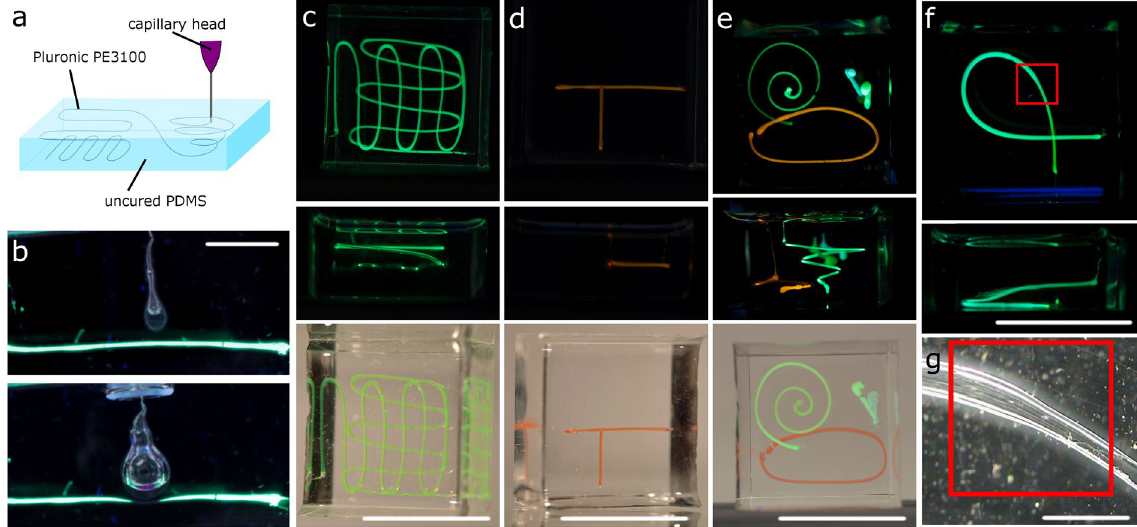
Figure 1. 3D printing of microfluidic channels in PMDS using Suspended Liquid Subtractive Lithography (SLSL). ( a ) Schematic of the SLSL method for printing channels directly into PDMS by injecting Pluronic PE3100 surfactant into uncured Elastosil 601. Printed channels were cleared from Pluronic PE3100 and filled with an aqueous solution of dye (green and orange). ( b ) Quake- type membrane actuator, with a fluid channel (bottom, green) and an expandable control channel on top. When the control channel is pressurized the channel expands, thus blocking the fluid channel, scale bar: 5 mm. Top images of ( c , d , e , f ) show the top view of the structure illuminated at 365 nm, middle images show the side view illuminated at 356 nm and bottom images show the structures at ambient light. ( c ) meander-like channel with two interconnected layers, scale bar: 18 mm, ( d ) T-junction, scale bar: 18 mm, ( e ) arbitrary structure of several z-layers and a three dimensional spiral, scale bar: 18 mm, ( f ) z-loop, scale bar: 18 mm, ( g ) close up of channel shown in ( f ) with a smooth transition between channel diameter of 550 µ m and 350 µ m manufactured by increasing the amount of extruded surfactant, scale bar: 1